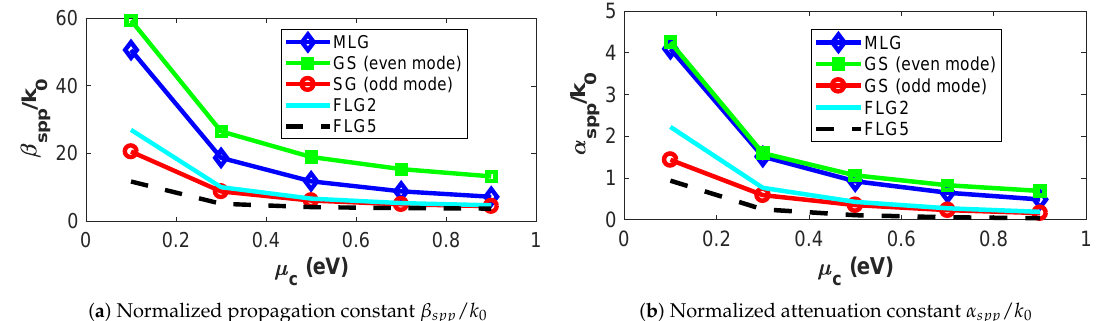
Figure 2. Normalized propagation and attenuation constant of the structures as a function of the chemical potential at 3